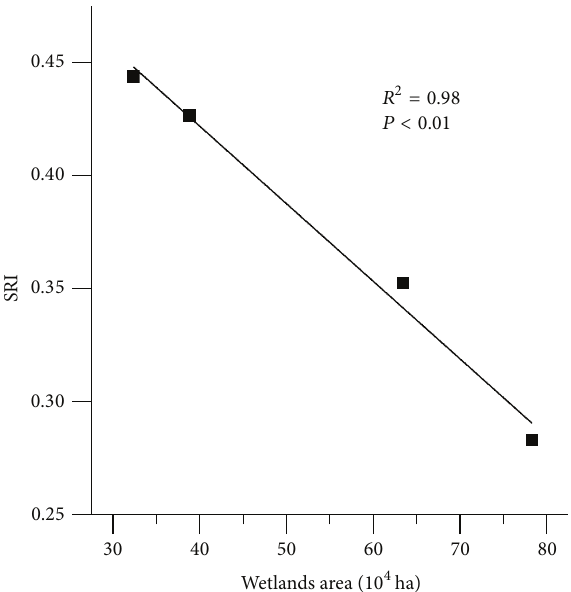
Figure 9: Scatter plot of wetlands area in subbasin 3 and the SRI of different 20yr